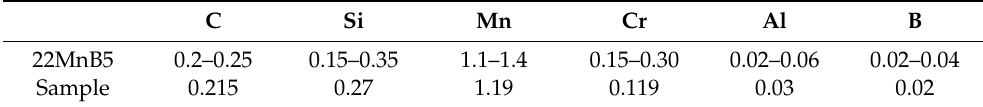
Table 1. Chemical composition of the studied material, compared to 22MnB5 standard; amounts in